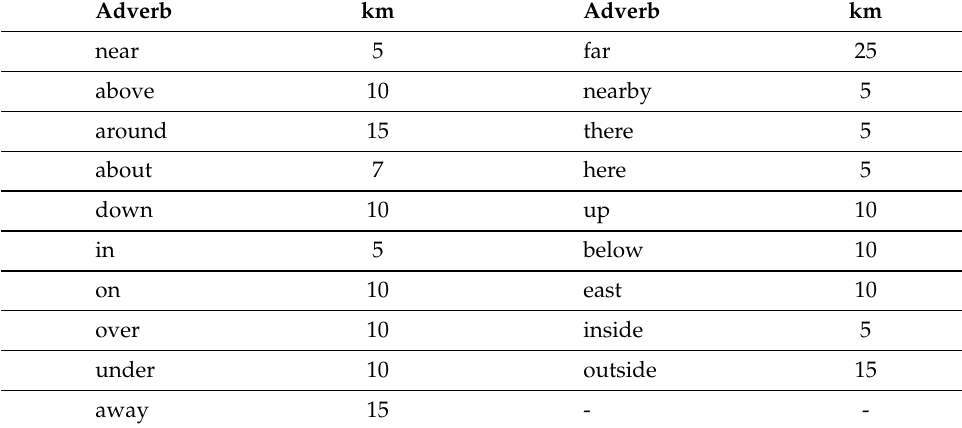
Table 4. Adverbs used by the geocoding system and movement size in